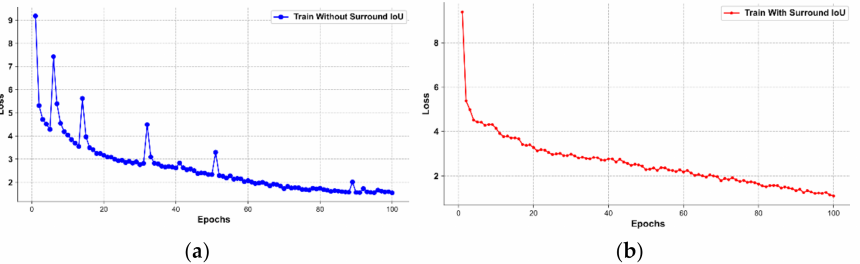
Figure 14. Comparisons of loss curves during training. Subfigure ( a ) represents the use of Smoothl1 Loss only, and subfigure ( b ) represents the use of Surround-IoU